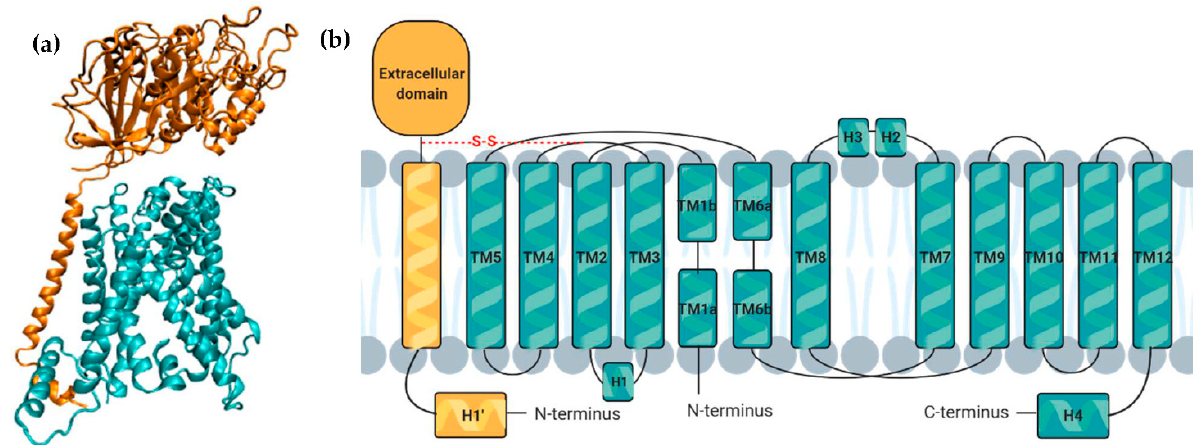
Figure 2. LAT1 structure. ( a ) Representation of the LAT1-4F2hc complex, with 4F2hc in orange and LAT1 in blue (PDB 6IRT); ( b ) Membrane topology of LAT1 transporter with the 4F2hc in yellow and the functional light chain LAT1 in blue. The disulfide bridge (S-S), that connects the two chains, is represented in red (adapted from [25] and created with BioRender.com). H: short helix, TM: transmembrane domain.